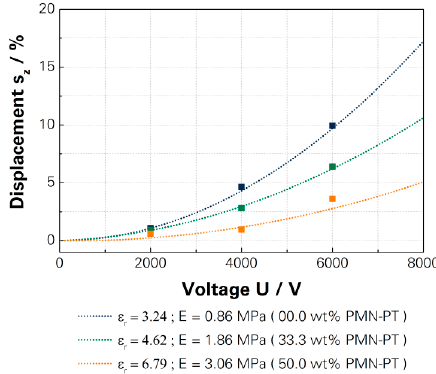
Figure 10. Measured actuation displacements and characteristic curves of full polymer DEA with different relative permittivities [15]—Table S1: actuators 2, 8 and 9.